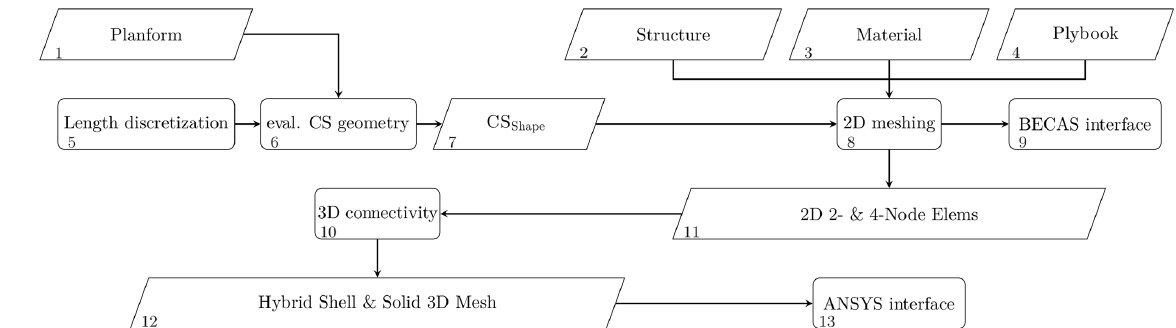
Figure 1. Flowchart of the finite-element model creation procedure in MoCA.